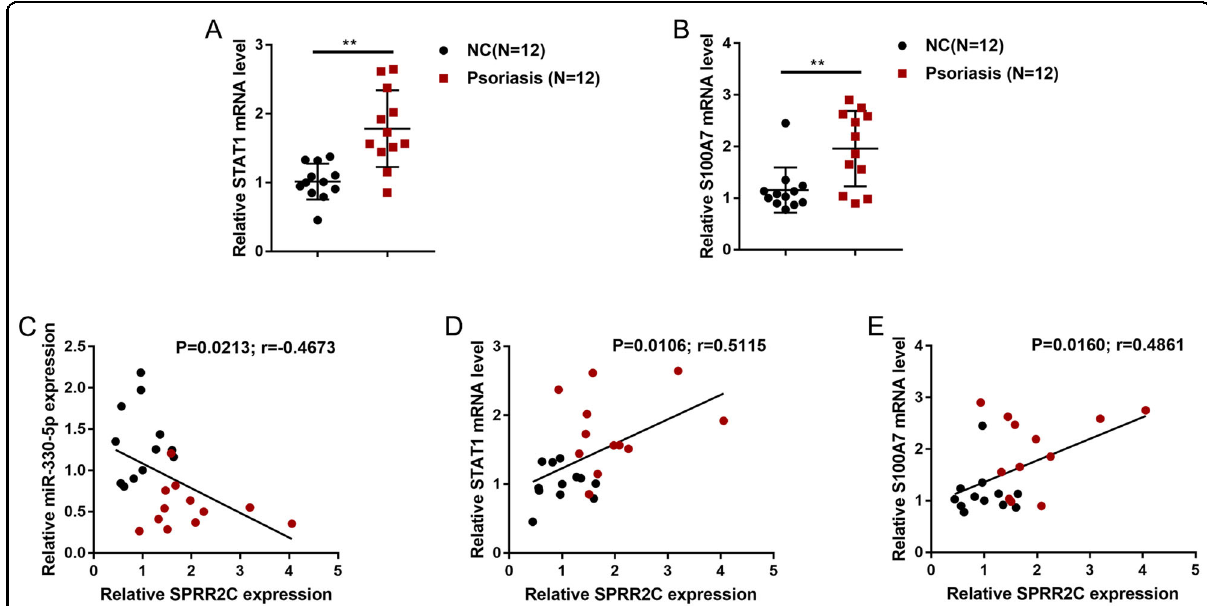
Fig. 7 Expression and correlation of related factors in tissue samples. A , B The expression of STAT1 and S100A7 was determined in 12 psoriatic lesions and 12 nonlesion tissue samples by real-time PCR. C – E The correlation of SPRR2C, miR-330, STAT1, and S100A7 expression was analyzed by Pearson ’ s correlation